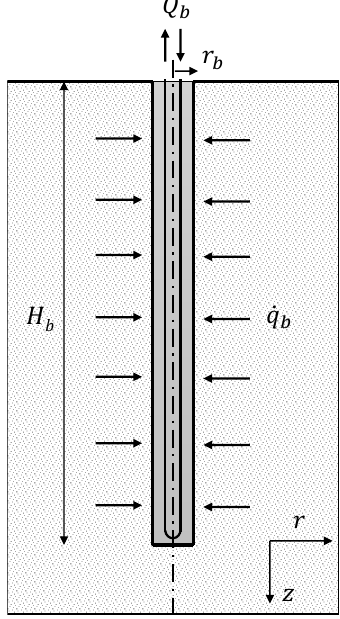
Figure 1. Schematic diagram of a typical borehole heat